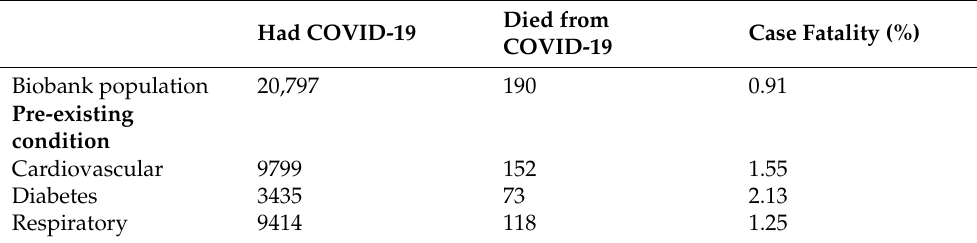
Table 3. COVID-19 case fatality. Case fatality overall and by pre-existing